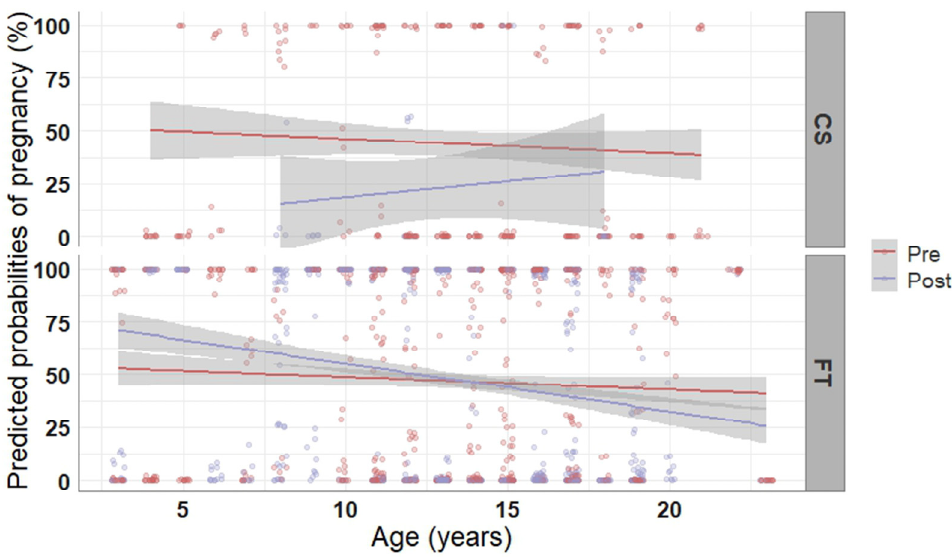
Figure 2. Predicted probabilities of pregnancy plotted in relation to the age of the mare, the time of artificial insemination, and the type of semen used. Pregnancy probabilities were computed based on 1755 observations of 210 mares using a generalized linear model. The mean probability of pregnancy with progressing age is represented with solid lines; the grey-shaded areas reflect the 95% confidence intervals of the mean probability line. CS, cooled-stored semen; FT, frozen-thawed sperm; Pre, prior to ovulation; Post, after ovulation.